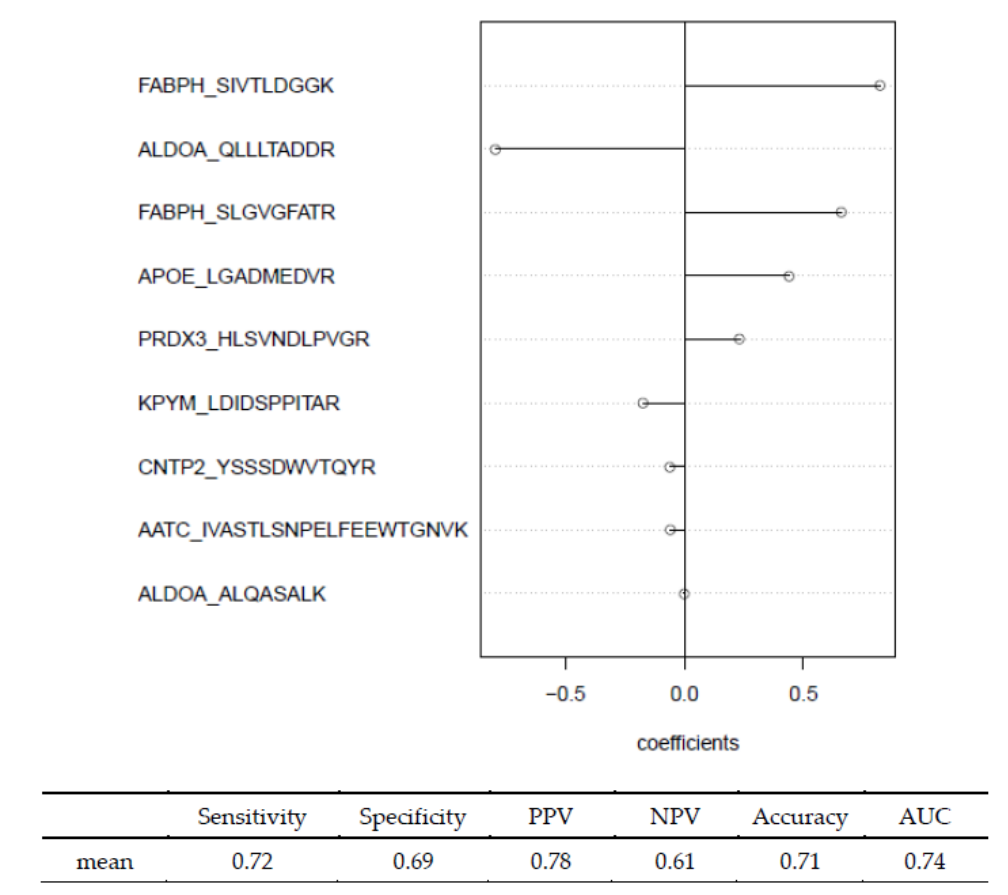
Figure 6. Signature identified by MCglmnet for classifying MCI and NL subjects, along with perfor- mance estimates derived via 5-fold outside cross-validation wrapper.